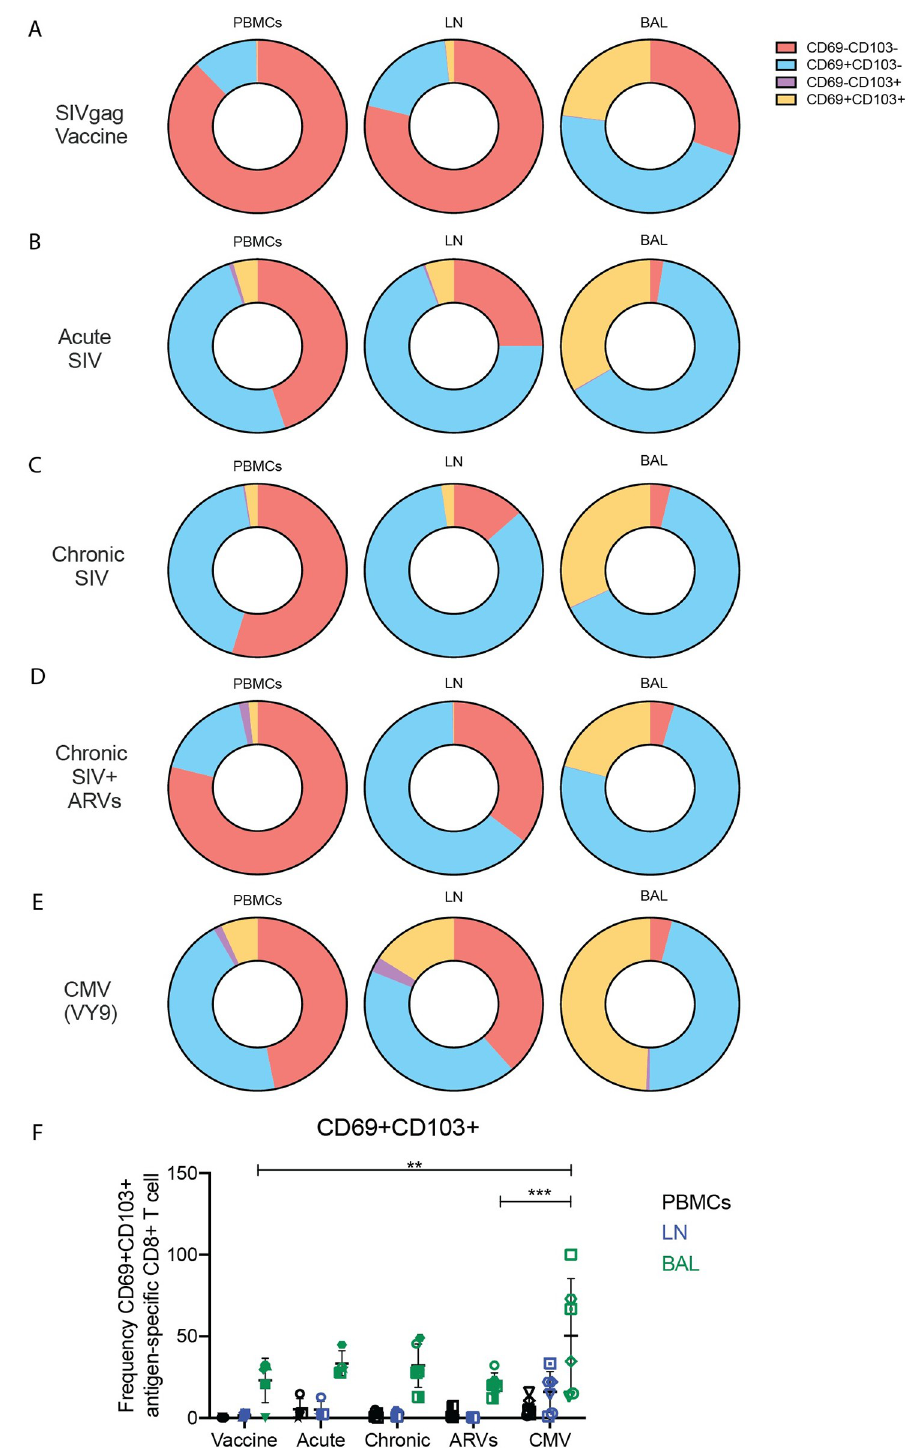
Fig 6. Expression patterns of CD69 and CD103 among virus-specific CD8 + T cells. The expression of CD69 and CD103 on antigen specific CD8 + T cells were assessed by flow cytometry across all experimental groups. (A-E) Average percentage of CD69 - CD103 - , CD69 + CD103 - , CD69 - CD103 + and CD69 + CD103 + antigen-specific (CM9) CD8 + T cells after exposure to SIV-gag DNA vaccine (A); during acute (B), chronic (C), and chronic SIVmac239X or SIVmac239 infection with ARV treatment (D); or during CMV infection (E). (F) The number of CD69 + CD103 + antigen-specific CD8 + T cells during all experimental conditions. In (F) data are presented as mean with SD. Two-way ANOVA was used to determine statistical significance in (F). n = 3 to 6 animals.